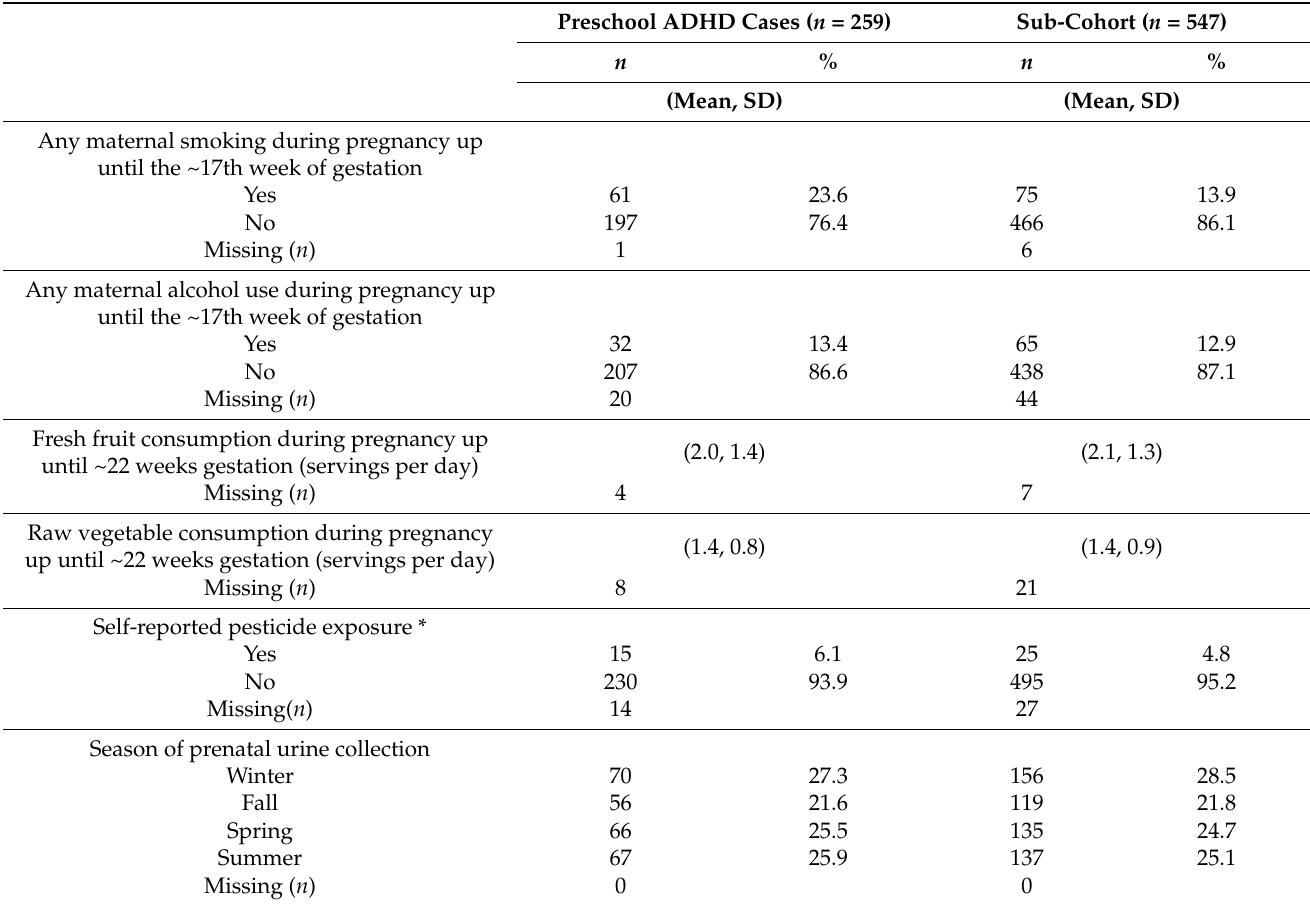
Table 2. Behavioral characteristics of study population in nested case–cohort study of preschool attention-deficit hyperactivity disorder in the Norwegian Mother, Father and Child Cohort (MoBa), birth years